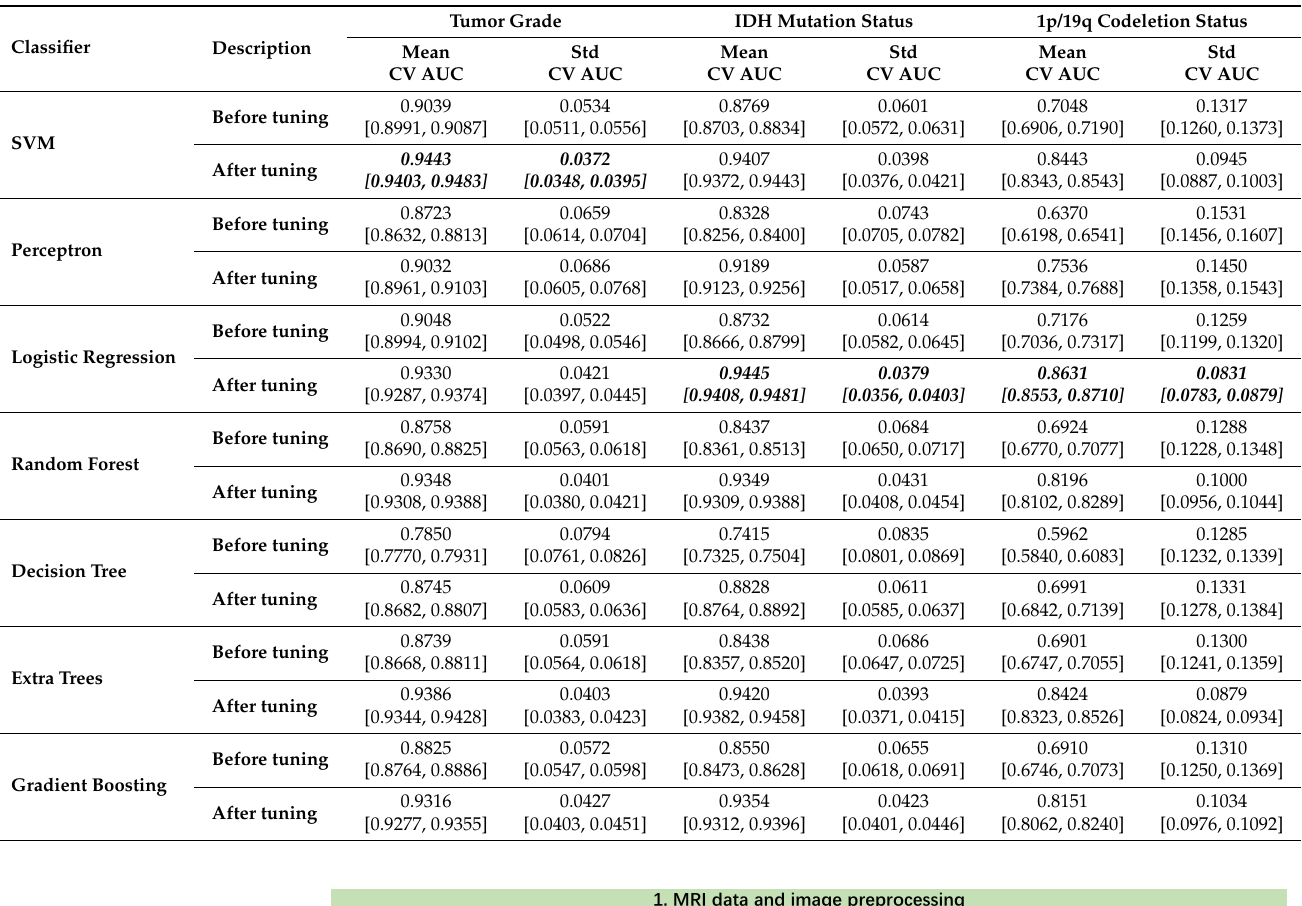
Table 2. Mean and standard deviation (STD) of the cross-validation (CV) AUC values during the cross-validation process for each classifier, before and after the pipeline tuning process. The table reports the average and 95% confidence interval (in square brackets), computed over 51 random realizations, of the mean/std cross-validation AUC for predicting the glioma grade, IDH mutation status, and 1p/19q codeletion status. The best performance for each task is marked in bold italics.